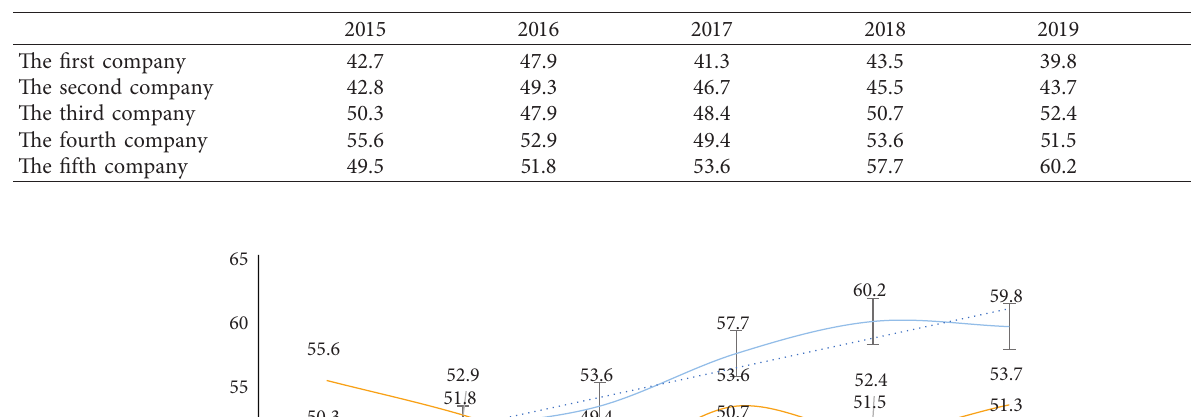
Table 3: Executive compensation.